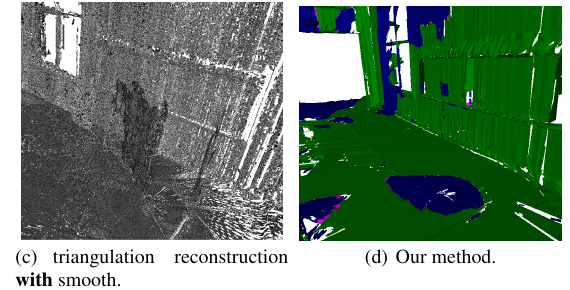
Figure 13. A comparison if there is a moving person with Pois- son reconstruction(implicit method) and triangulation reconstruc- tion(explicit method).